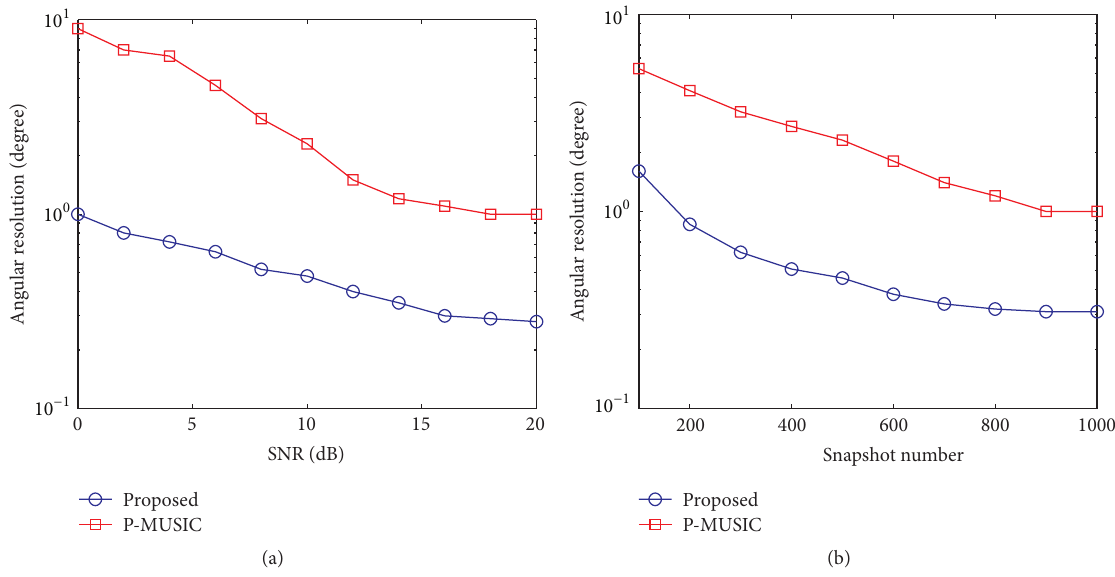
Figure 8: Angular resolution versus SNR and snapshot number: (a) RMSE versus SNR with the fixed snapshot number, 500; (b) RMSE versus snapshot number with the fixed SNR